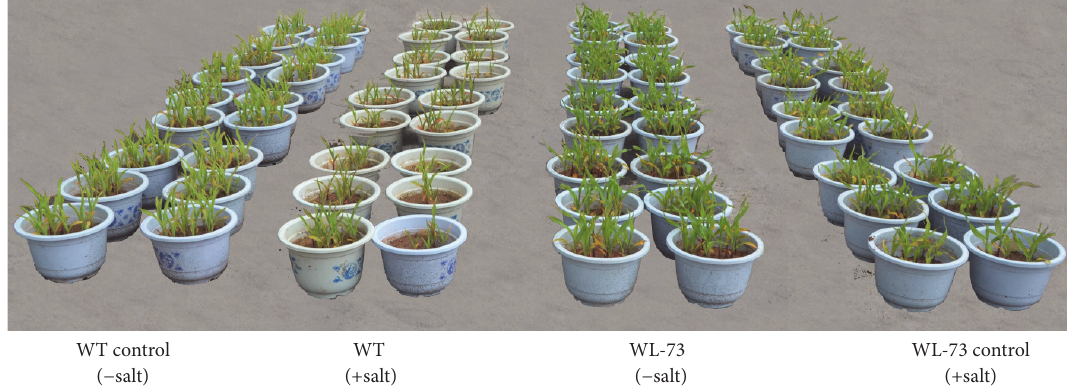
Figure 3: Enhanced salt tolerance of transgenic versus wild-type seedlings under 300 mM NaCl. Wild-type and transgenic maize plants were treatedwith0.5xHoagland’snutrientsolutionandeither0 mMNaCl(control)or300 mMNaClfor7days.WL-73,LH1037plantstransformed with BcWRKY1 ; WT, wild-type LH1037 plants. Note: salt tolerance of transgenic maize compared to WT. Photographs were taken after salt